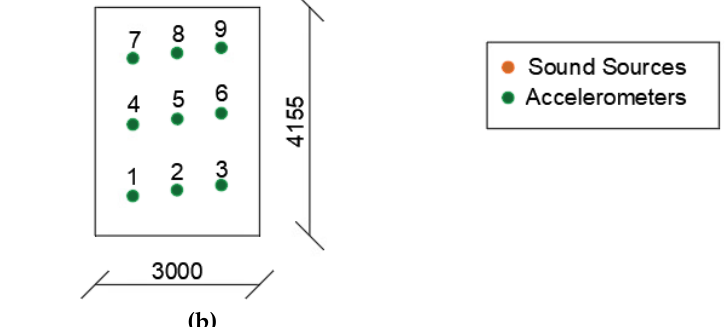
Figure 5. General scheme of the positioning of the sound sources ( a ) and the accelerometer ( b ) for the determination of the velocity levels.